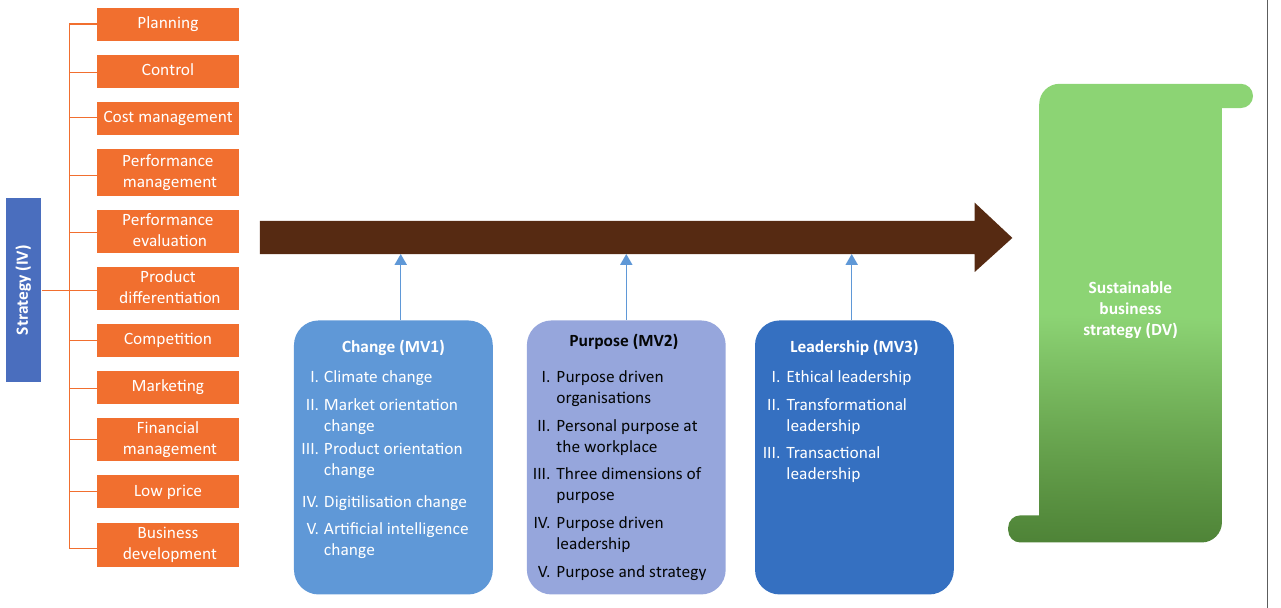
FIGURE 2: Conceptual framework – Development of a sustainable business strategy.